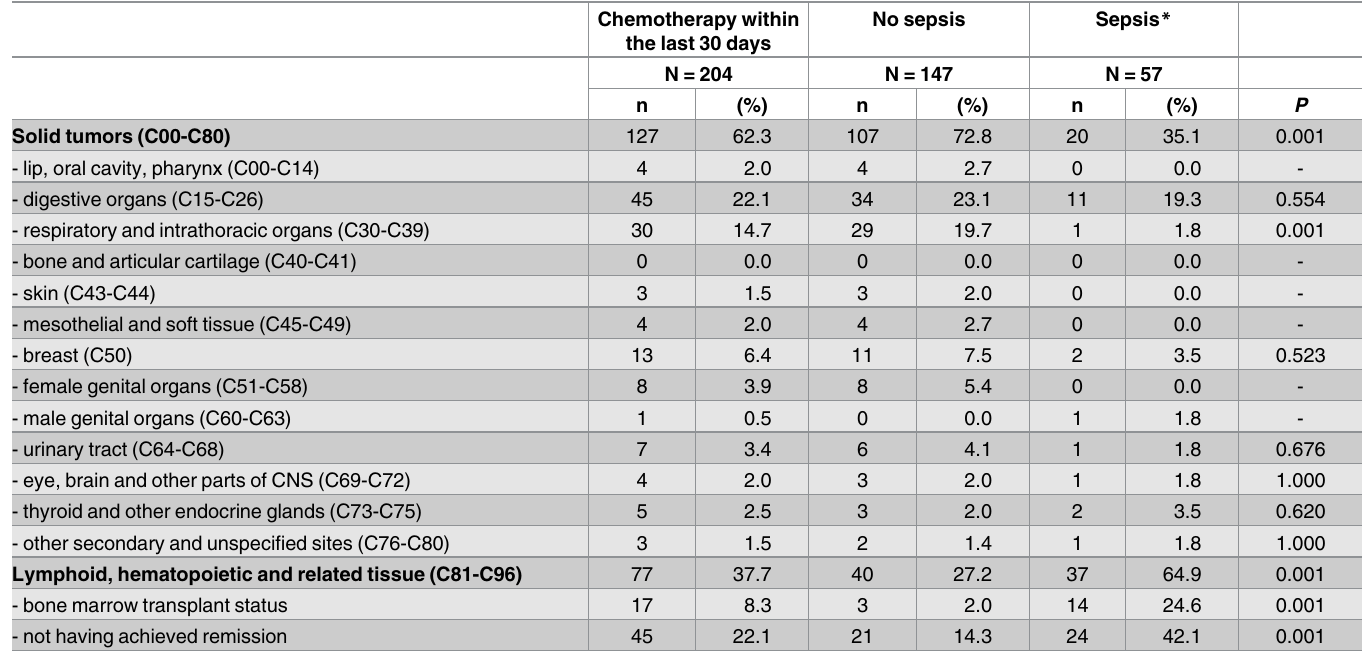
Table 7. Cancer patients with chemotherapy treatment in the last month of life—frequencies of sepsis stratified by tumor